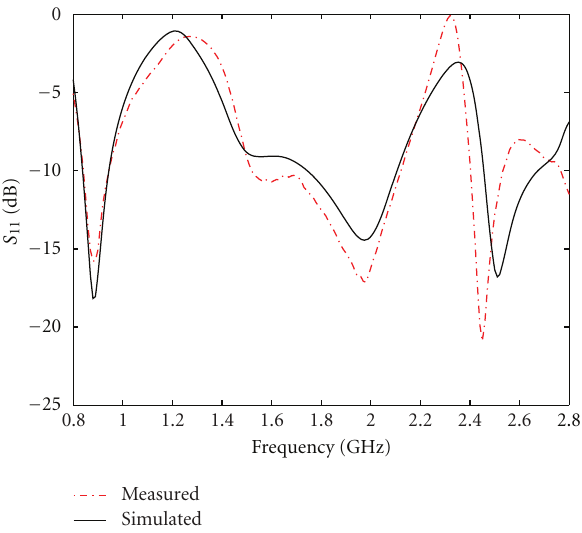
Figure 4: Measured and simulated S 21 of the proposed